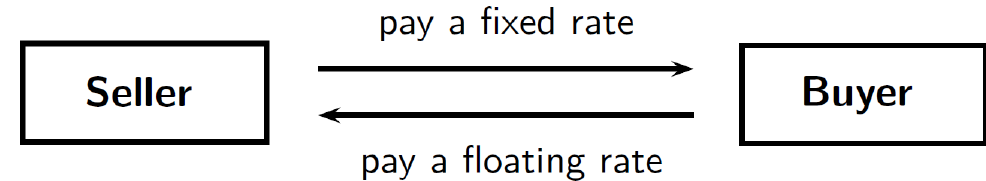
Figure 4. Mechanic of a fix-to-floating interest rate